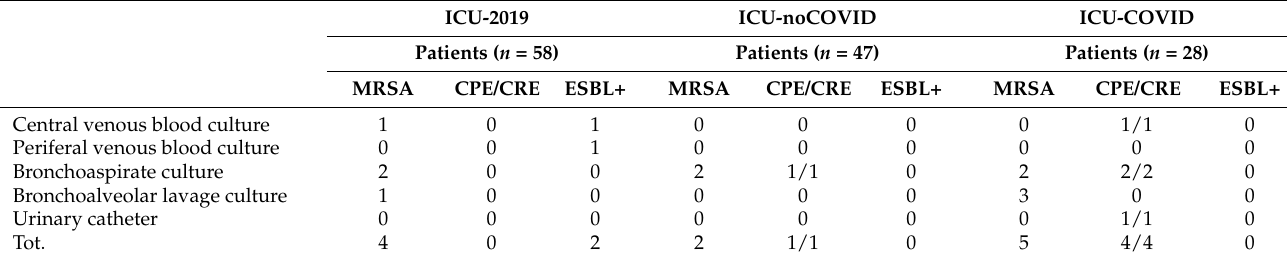
Table 4. Resistant bacteria isolated in three